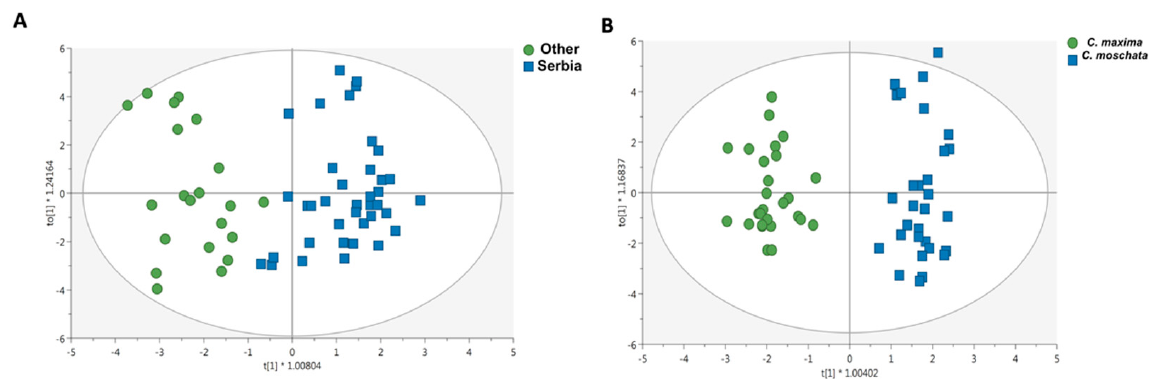
Figure 4. OPLS-DA score scatter plot obtained considering the discrimination based on the lipidomic profiles of the pumpkin samples originally from Serbia and those originating outside Serbia ( A ), and when considering the plant species ( B ), i.e., C. maxima vs. C. moschata .